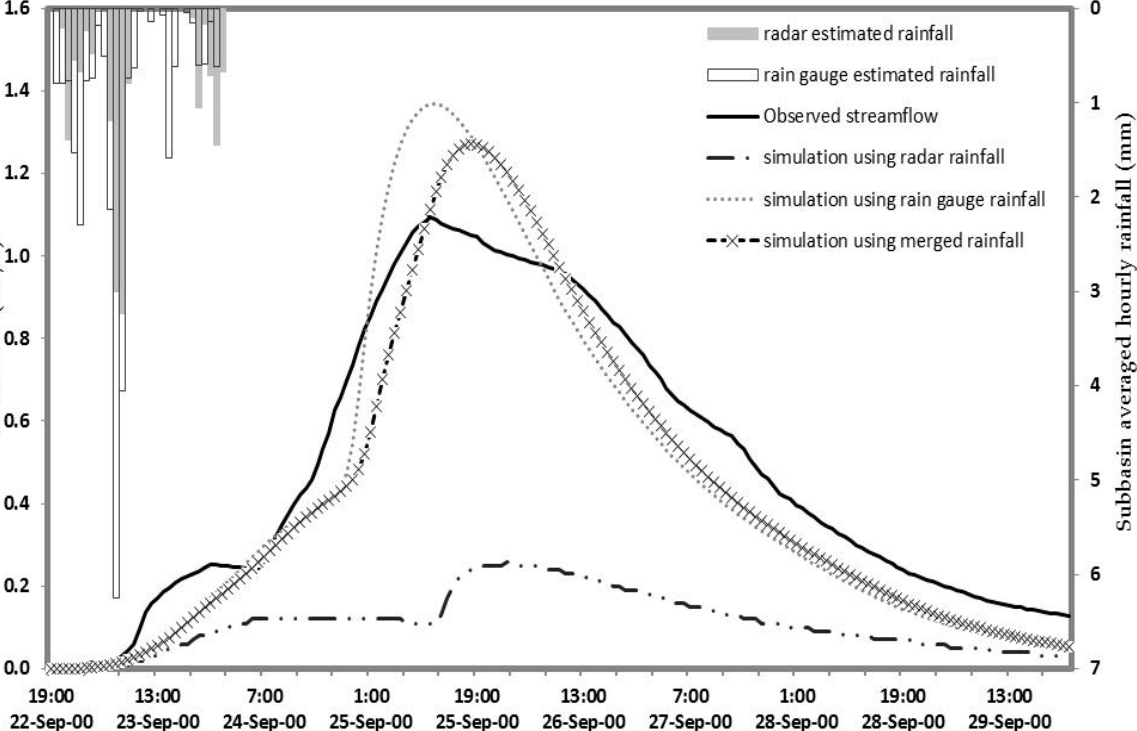
Figure 11. Comparison of estimated and observed hydrographs using different rainfall estimates for the 9 July 2000 event with SCS modeling option.